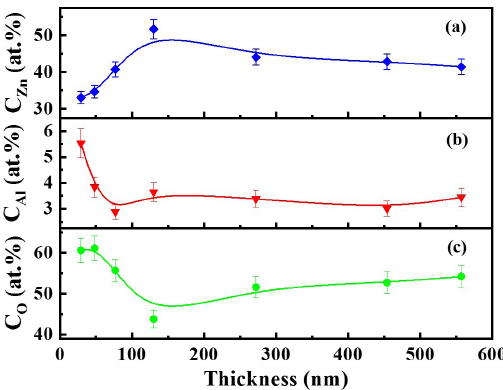
Figure 2. Concentrations of (a) Zn, (b) Al and (c) O measured using